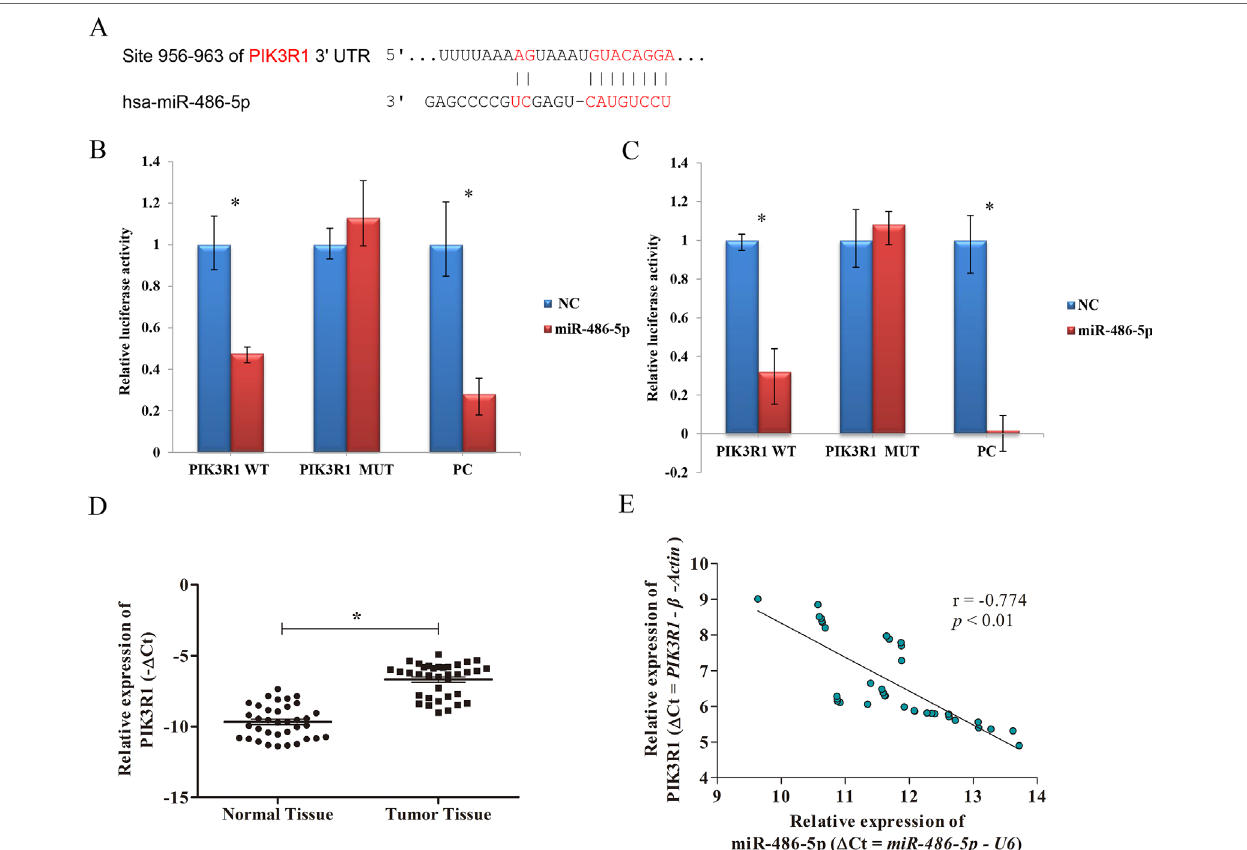
FIGURE 3 | The correlation of PIK3R1 and miR-486-5p expression levels. (A) PIK3R1 3’-UTR contains miR-486-5p binding sites. The alignment of the seed region of miR-486-5p and the site of target were indicated in red. (B , C) The luciferase reporter assay showed that the luciferase activity of PIK3R1-3’-UTR wild type (WT) was significantly reduced in cells expressing miR-486-5p compared with those expressing negative control (NC) ( p < 0.01), but the luciferase activity of PIK3R1-3’- UTR mutation type (MUT) did not reveal significant changes after 24 h (B) and 48 h (C) . The positive control (PC) also exhibited reduction of luciferase activity after 24 and 48 h with transfection ( p < 0.01). (D) The expression level of PIK3R1 was upregulated in NSCLC tumor tissue compared to the normal tissue ( p < 0.05, n = 36). (E) Upregulation of PIK3R1 was negatively correlated with downregulation of miR-486-5p in NSCLC tissue by ΔCt ( r = −0.774, p < 0.01, n = 36). * p <